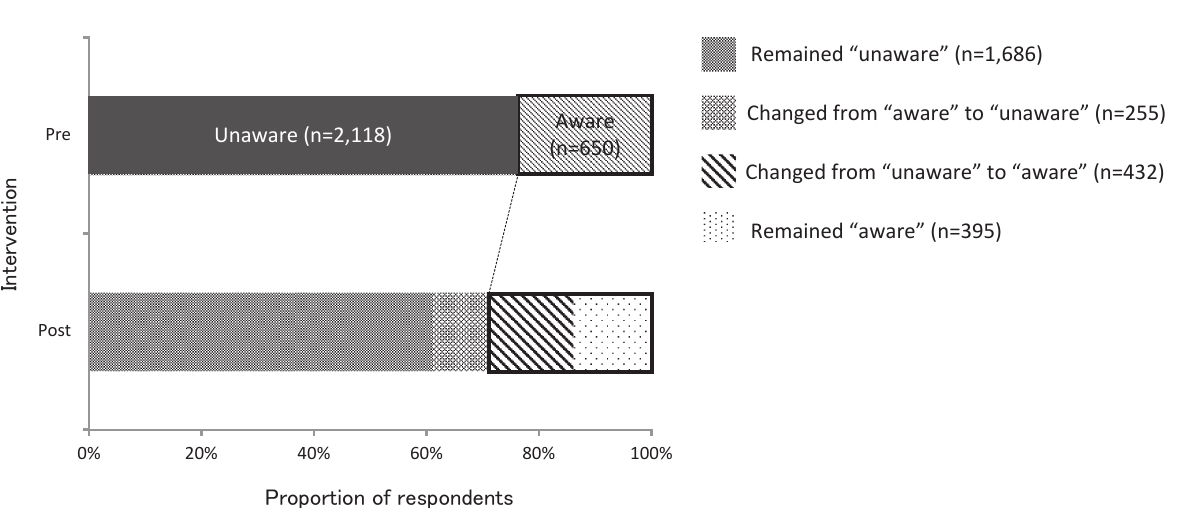
Table 2. The improvement of the knowledge of stroke symptoms; those who chose 5 correct stroke symptoms and the rest Akita (Intensive)